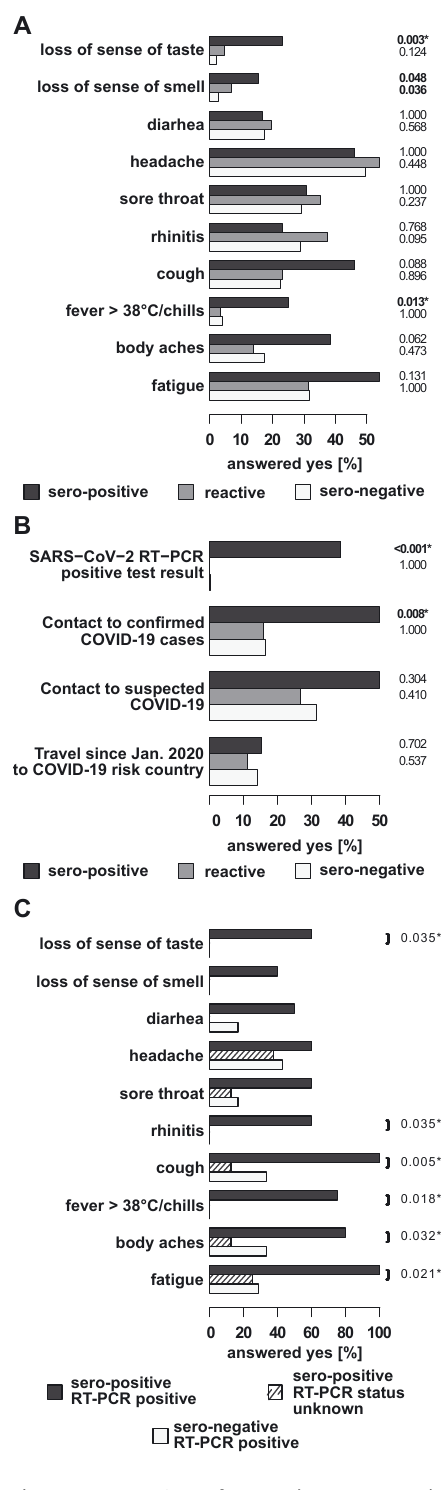
Figure 3: Comparison of reported symptoms and COVID-19 related history items in sero-positive, reactive, and sero-negative employees. (A)Thehorizontalbarsontheleftindicatethepercentageoftheanswer “ yes ” to the indicated items among the sero-positive, reactive, and sero-negative employees. p-values set in bold indicate a